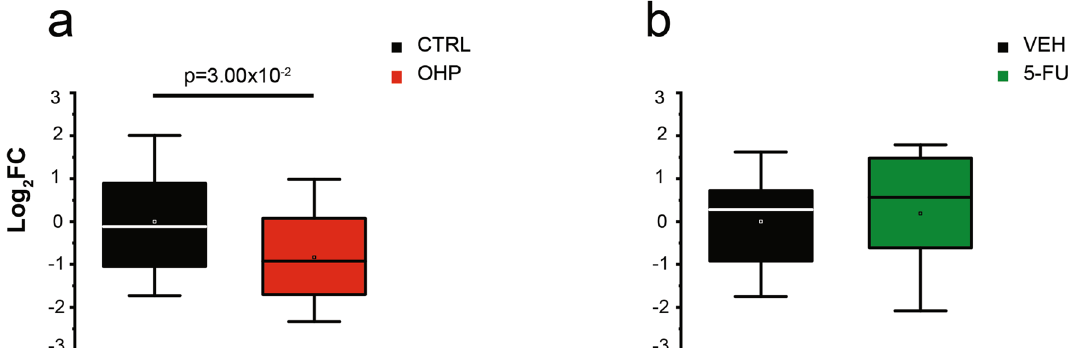
Figure 4. OHP affects the transcription of NHE1 in DRG cultures. Mean (square), the median (line across the box), and interquartile range (box) of treated vs. control or vehicle log 2 FC of gene expression, as measured through real-time quantitative PCR (RT-qPCR). ( a ) OHP-induced changes in mRNA level were measured in cultured DRG neurons from mice, after 6 h of treatment. ( b ) mRNA expression from DRG neurons was also measured after 5-FU